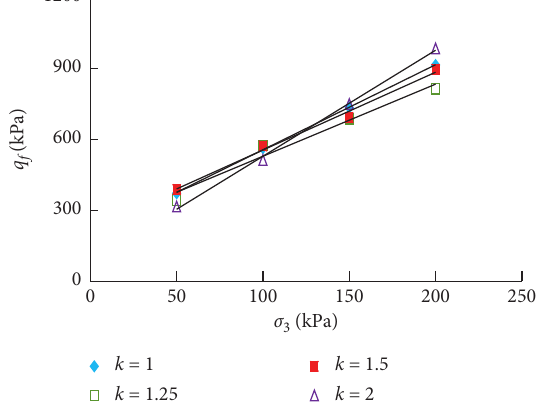
Figure 15: Change law between q